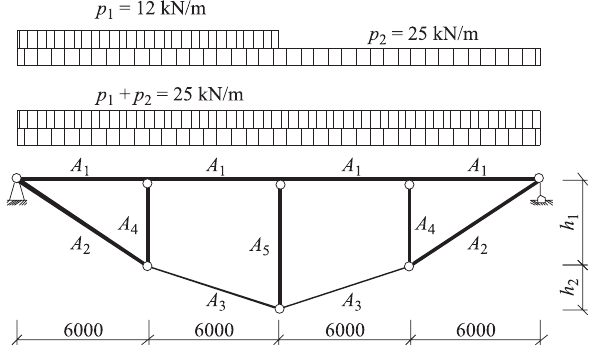
Fig. 9. Design diagram of the bridge truss